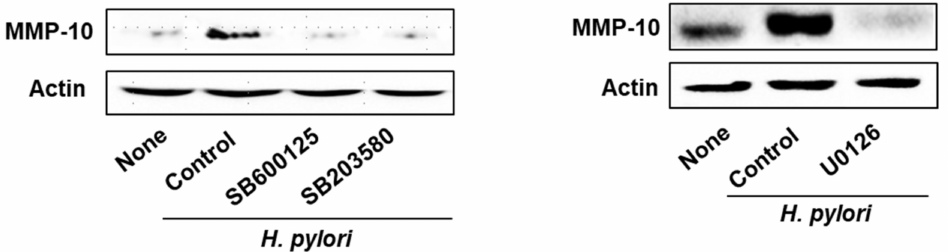
Figure 2. JNK, p38, and ERK inhibitors reduced H. pylori -induced MMP-10 expression in AGS cells. The cells were pretreated with SB600125 (a JNK inhibitor, 20 µ M) or SB203580 (a p38 inhibitor, 20 µ M) for 60 min, or U0126 (an ERK inhibitor, 10 µ M) for 30 min, and then infected with H. pylori for 24 h. MMP-10 levels were determined by Western blot analysis. Actin was used as a loading